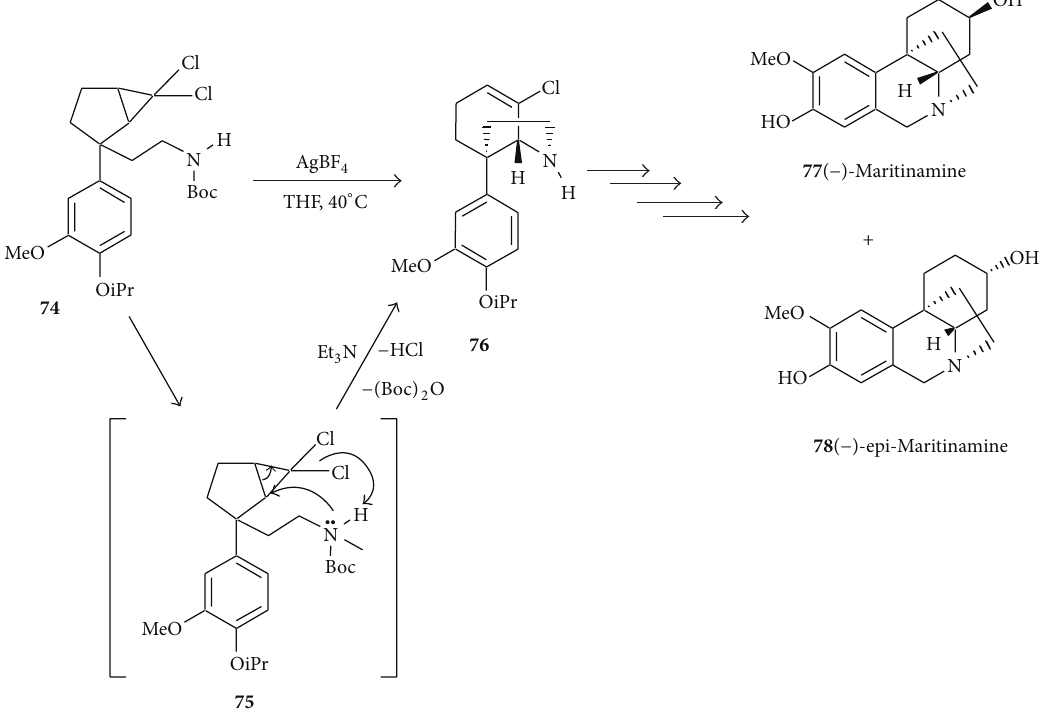
Scheme 14: Synthesis of epi-Maritinamine 78